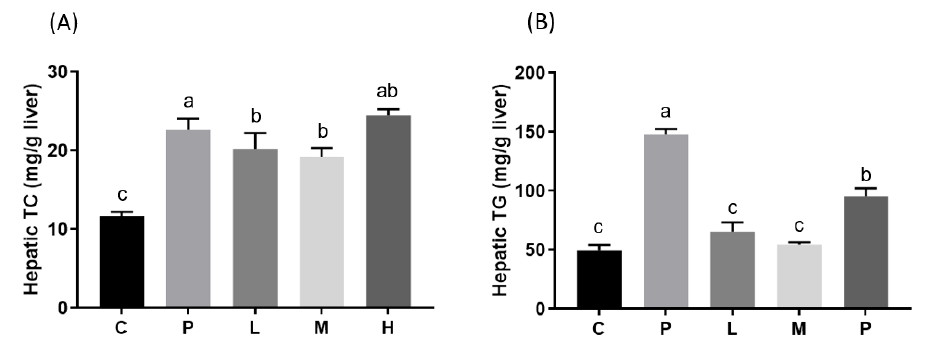
Figure 2. Hepatic ( A ) TC and ( B ) TG concentrations in hamsters fed a HFD after a melatonin intervention for eight weeks. Daily gavage administration of melatonin at 10 (L), 20 (M), or 50 (H) mg/kg, or the ethanol vehicle to hamsters fed a HFD (P) or control diet (C). All values are the mean ± SEM ( n = 6–8). Different letters (a, b, c) indicate a significant difference at p < 0.05 determined using two-way